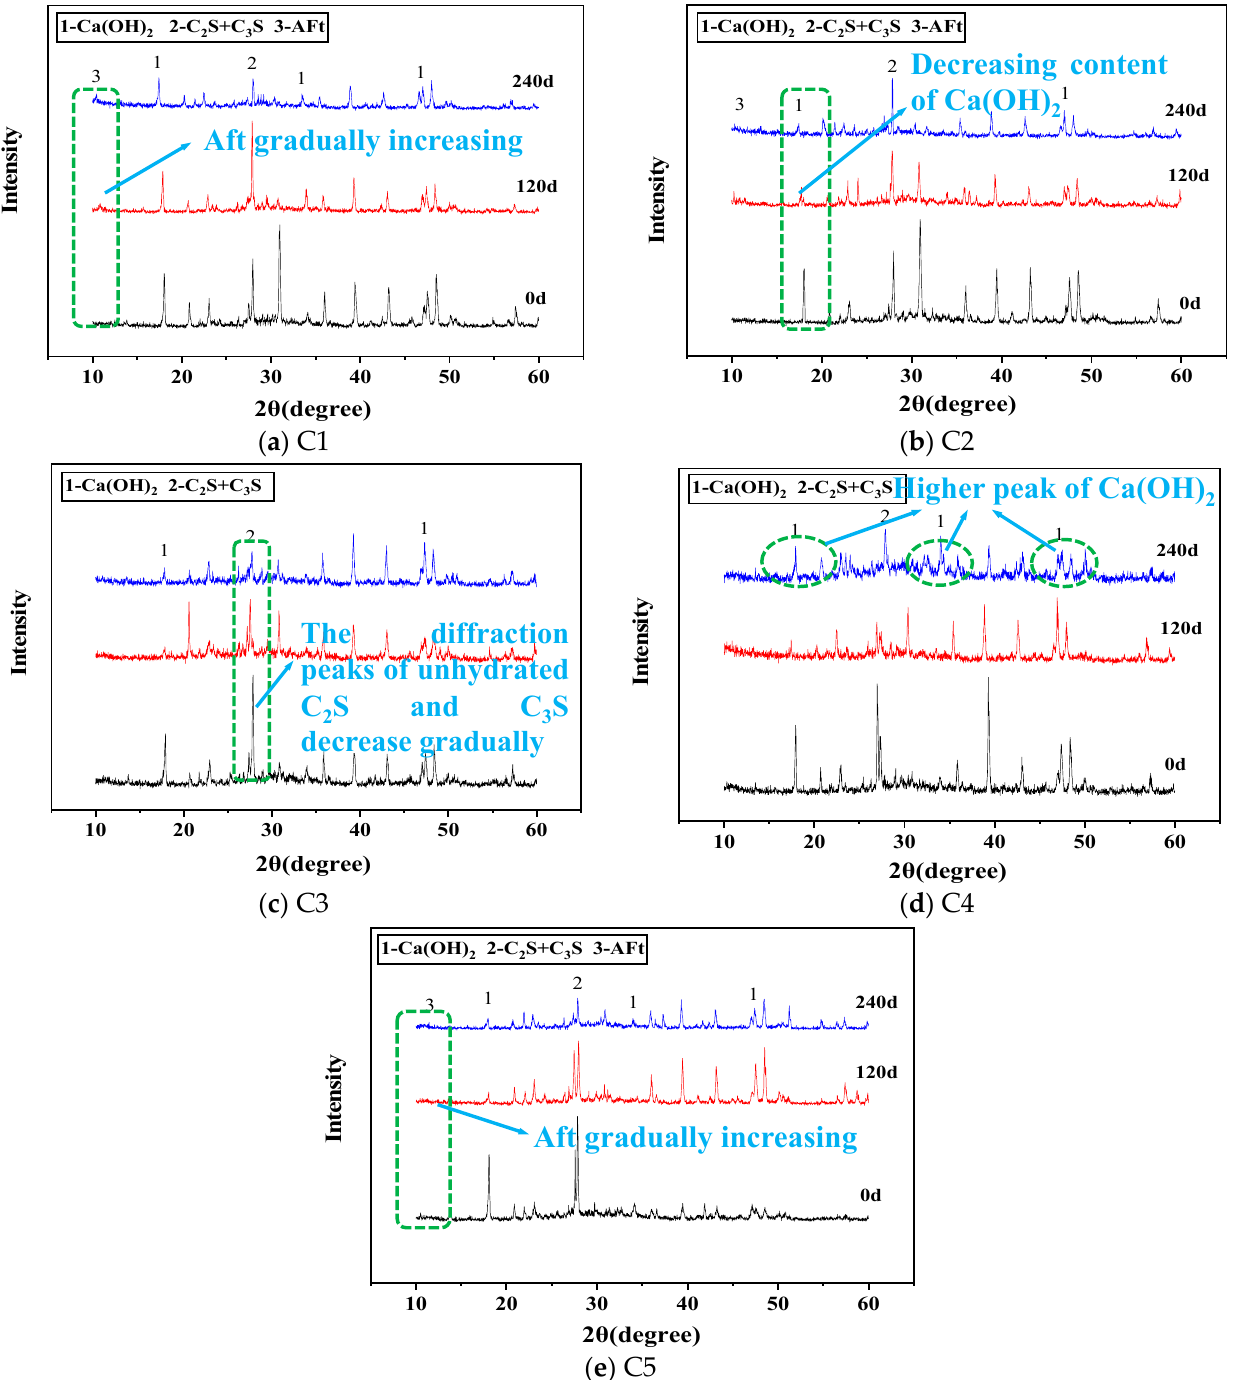
Figure 5. X-ray diffraction of hydration products of concrete with different fitting ratios.